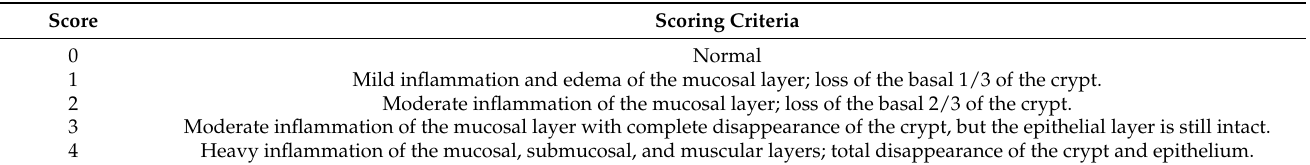
Table 2. The criteria for histopathology score.